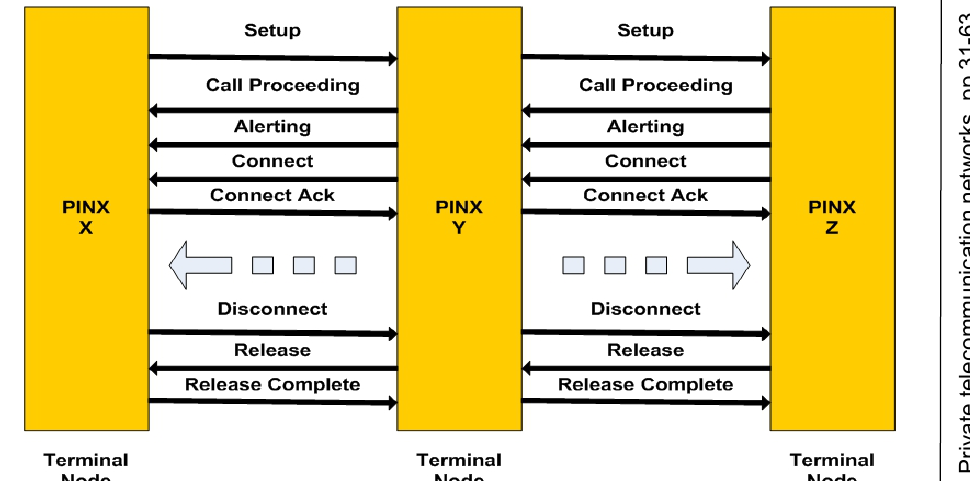
Figure 1 – Sequence of messaging at Q-SIG BC which includes the transit node in the network (InterConnect Communication, 1995) Рис . 1 – Последовательность обмена сообщениями в Q-SIG BC, включающая транзитный узел в сети (InterConnect Communication, 1995) Слика 1 – Секвенца размена порука при Q-SIG BC која обухвата и транзитни чвор у мрежи (InterConnect Communication,